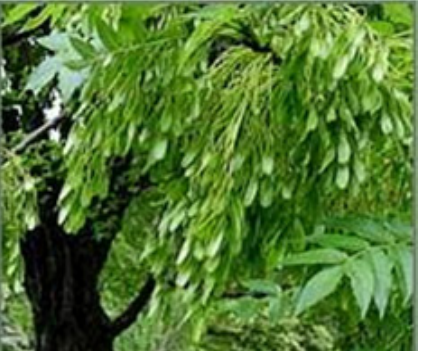
Fig. 3: Specimen of the dust collector